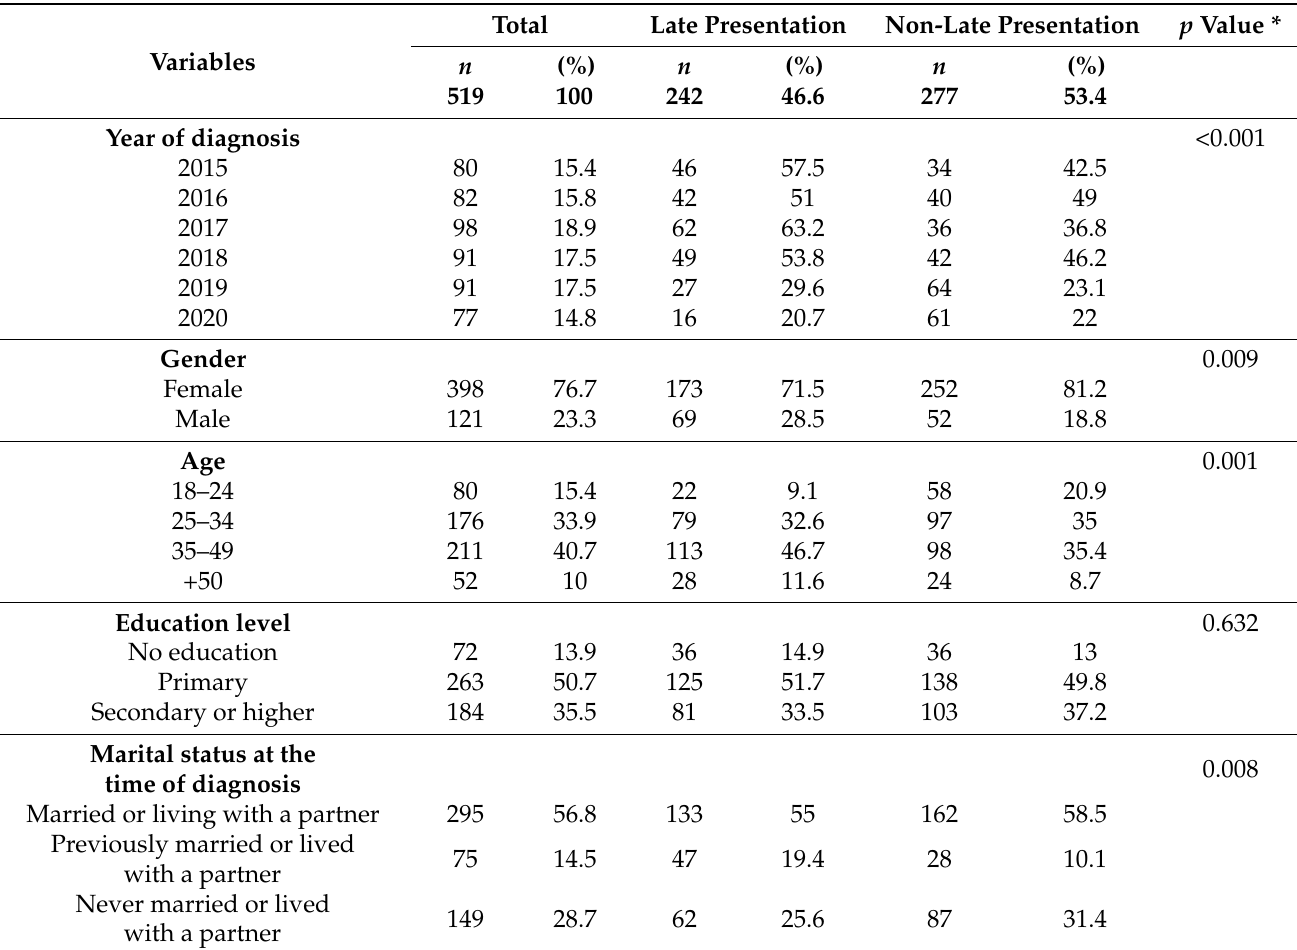
Table 1. Sociodemographic characteristics of study participants and clinical factors of study partici- pants at the Ndlavela Health Center,